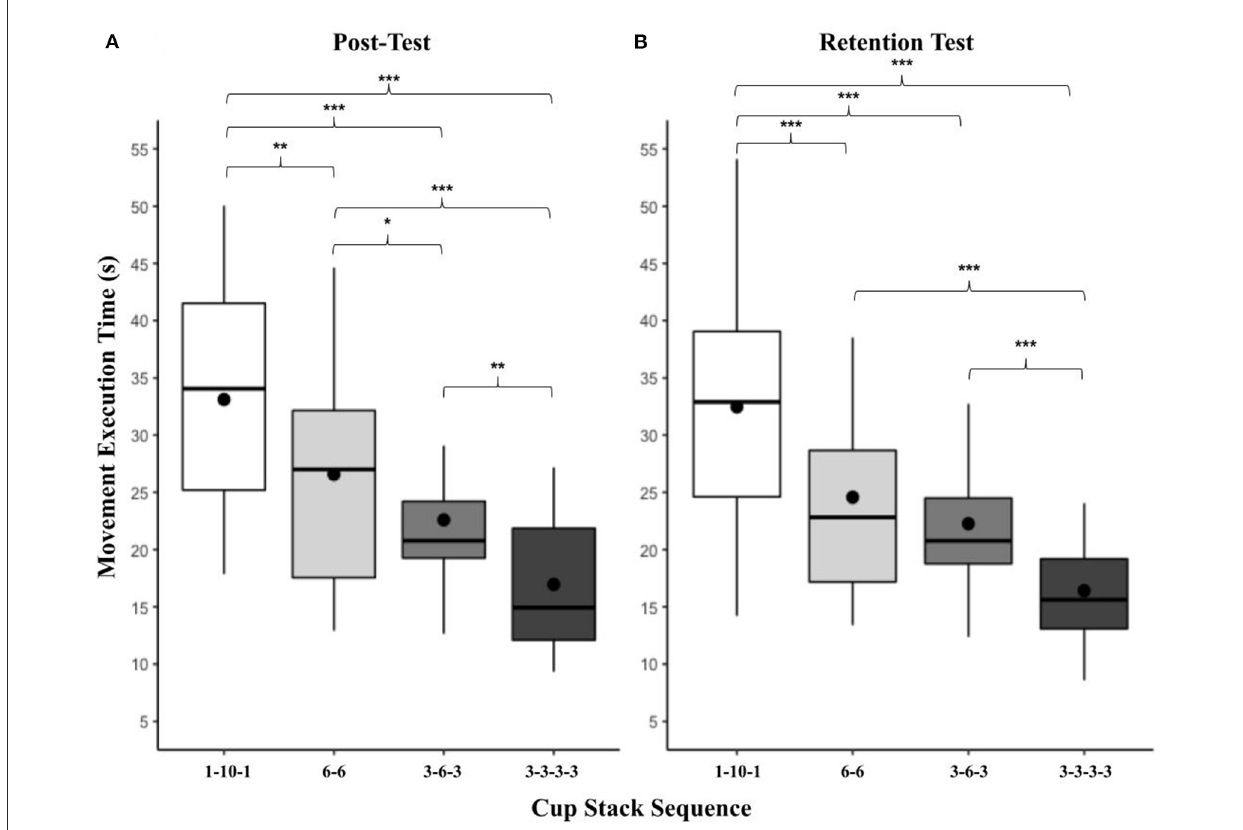
FIGURE5 (A, B) Box and whisker plot displaying movement execution times at post and retention for task. This figure shows the distribution of movement execution time data and skewness for all cup-stack tasks at the post and retention test time points. These data are presented by displaying a six-number summary including: the minimum score (bottom of lowest line), first (lower) quartile (lower line), median (black horizontal line), third (upper) quartile (upper line), mean (black dot) and maximum score (top of upper line); * p < 0.05; ** p < 0.01; *** p <